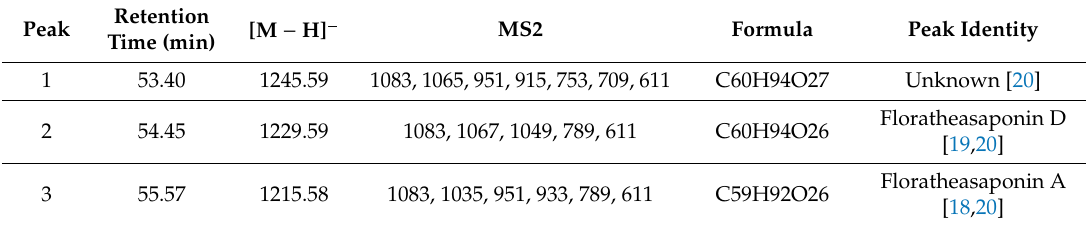
Figure 1. Typical chromatograms of BTFS. ( A ) Ultraviolet chromatograms. ( B ) Total ion chromatograms. Table 1. MS data in negative mode of saponins extracted from tea flower.